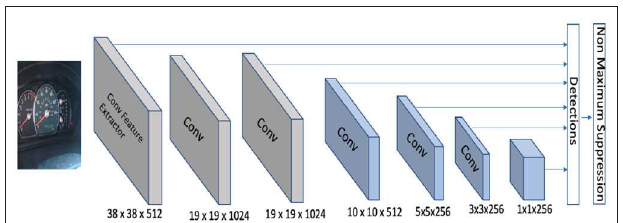
FIGURE 2 | Single Shot Detector extracts detections from feature map at multiple